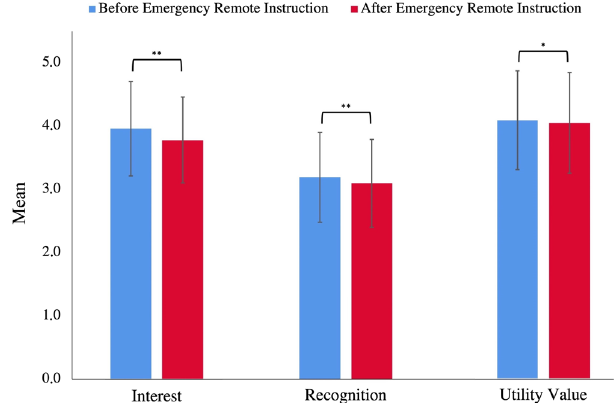
FIG. 4. Mean values of the raw scores of the three latent factors of the motivational construct before and after emergency remote instruction. Whiskers indicate standard deviation. * p < 0 . 05 ; ** p < 0 . 01